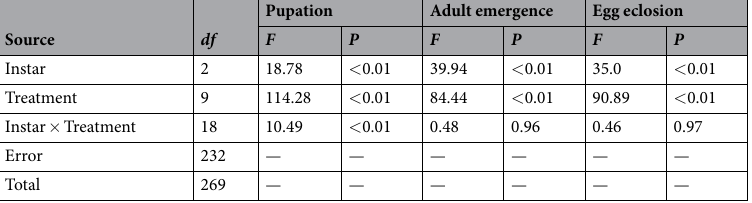
4 Scientific RepoRts | 7: 5971 | DOI:10.1038/s41598-017-05615-3